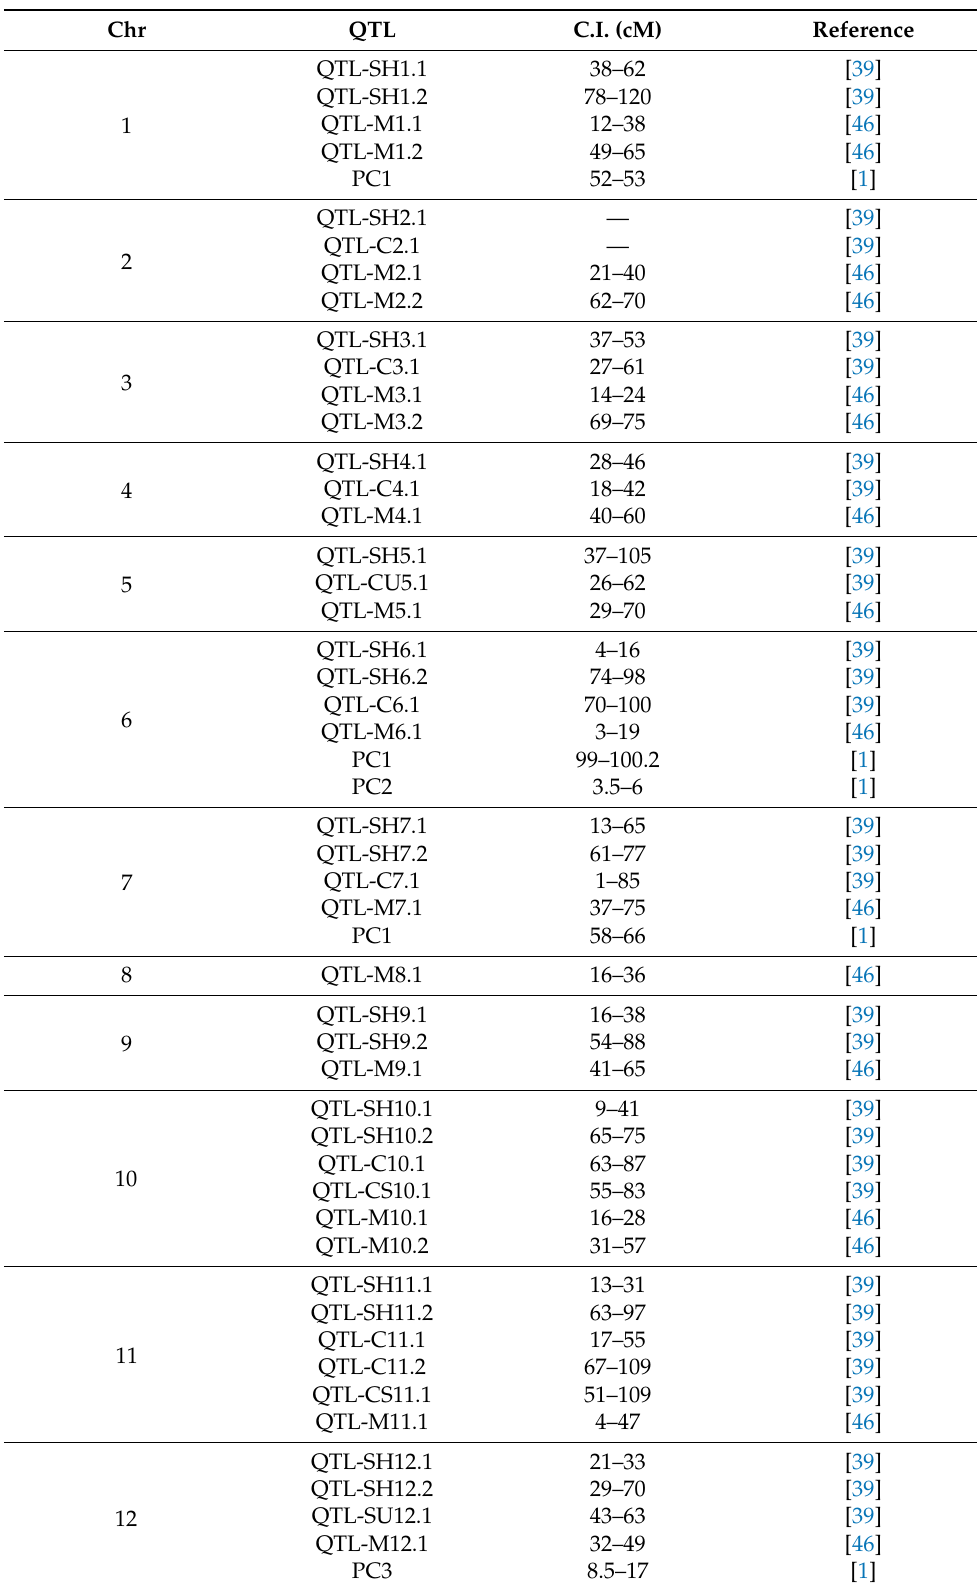
Table 1. Locations and confidence intervals (CI) of significant QTLs for the size (mean of the two sides) of the mandible characters (M), shape (SH), centroid size (C) and facial shape principal components (PCs) given as map distances from the nearest proximal marker and from the centromere after QTL analysis in mouse